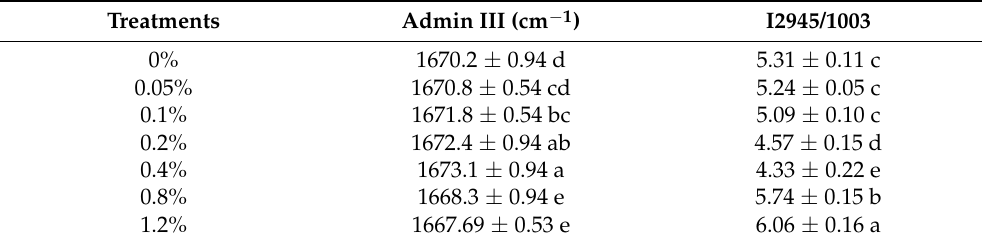
Table 4. The frequency of characteristic peak in Admin III and normalized intensities of 2945 cm − 1 band of composite MP gels with various